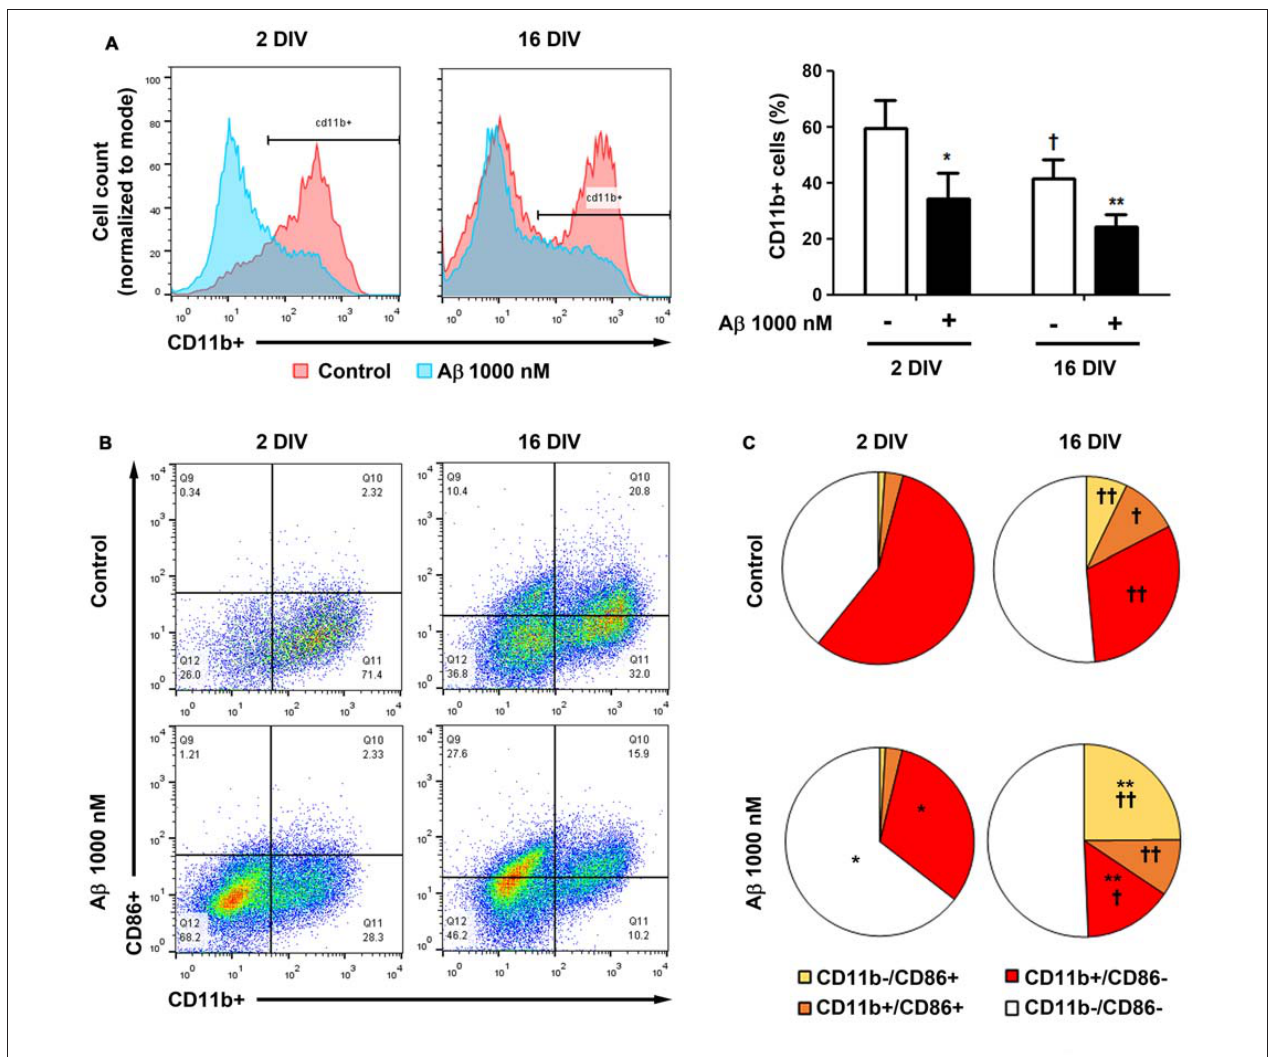
FIGURE 11 | Cell aging and treatment with amyloid- β (A β ) peptide decrease the population of microglia CD11b+ cells, while increase the number of CD86+ cells. Microglia that were kept in culture for 2 and 16 days in vitro (DIV) were treated with 1000 nM A β for 24 h. The population of CD11b+ and CD86+ cells was detected by flow cytometry. (A) Analysis of microglia expressing CD11b. Results are expressed in graph bars as mean ± SEM. Cultures, n = 4 per group. Two-way ANOVA ( Post hoc Bonferroni test): ∗ p < 0.05 and ∗∗ p < 0.01 vs. respective non-treated Control; † p < 0.05 vs. 2 DIV cells. (B) Representative flow cytogram of CD11b+ and CD86+ cells in reactive (2 DIV) and aged (16 DIV) cultured microglia. (C) Results are expressed in 2D pie graphs as mean. Cultures, n = 4 per group. Two-way ANOVA ( Post hoc Bonferroni test): ∗ p < 0.05 and ∗∗ p < 0.01 vs. respective non-treated Control; † p < 0.05 and †† p < 0.01 vs. 2 DIV